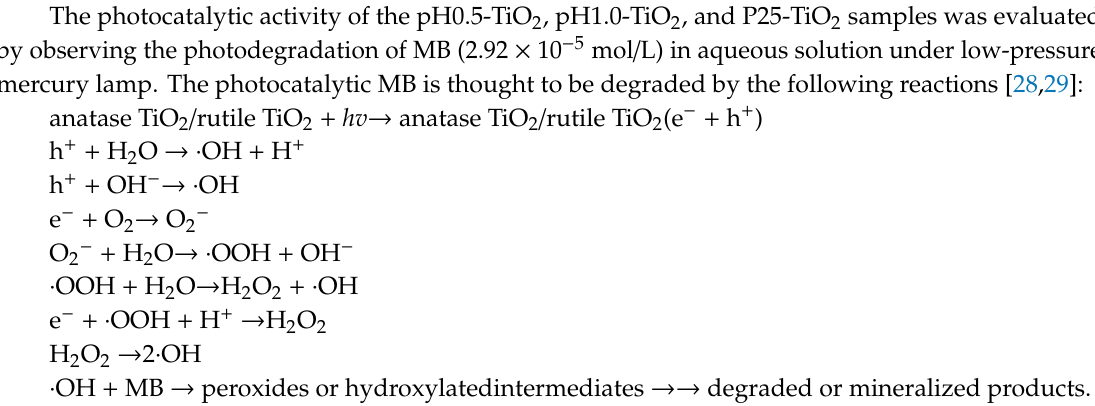
Figure 4. Particle size distribution of ( a ) pH0.5-TiO 2 and ( b ) pH1.0-TiO 2 .